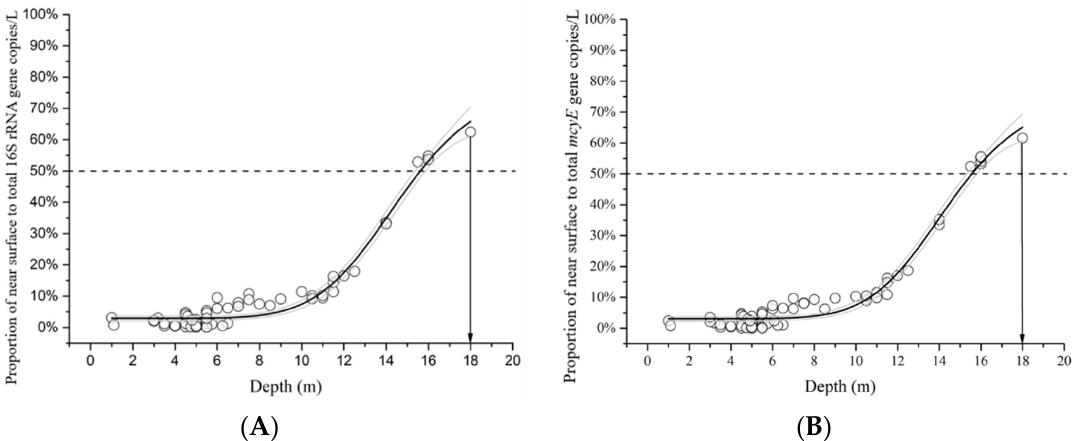
Figure 5. Ratio of near-surface to total M. aeruginosa 16S rRNA (A) and mcyE ( B ) concentration in gene copies per liter plotted against lakebed depth in meters near the Gilmour Point, Dog Lake field site. Ratio was calculated using raw data of concentrations of M. aeruginosa ( A ) 16S rRNA and ( B ) mcyE gene concentrations (copies/L) at each sampling site. Dark solid line shows best logistic fitting and its 95% confidence intervals (gray solid lines). R 2 16S = 0.97, R 2 mcyE = 0.98. Graphed log 10 transformed data is on Supplementary Figure